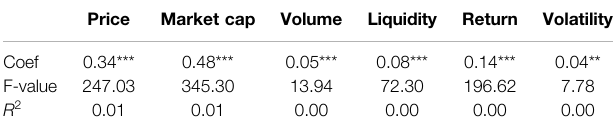
TABLE 5 | Regressions between the partial correlations of market indicators and the Jaccard similarity between nodes (model 3).